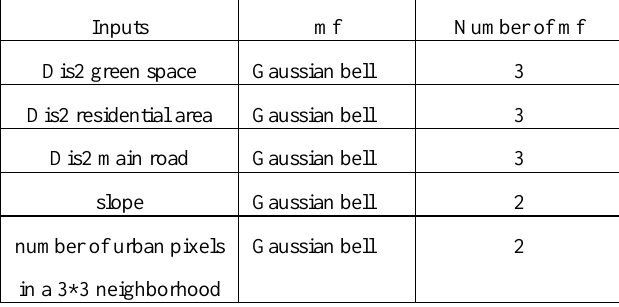
Table 1. Membership functions for each input